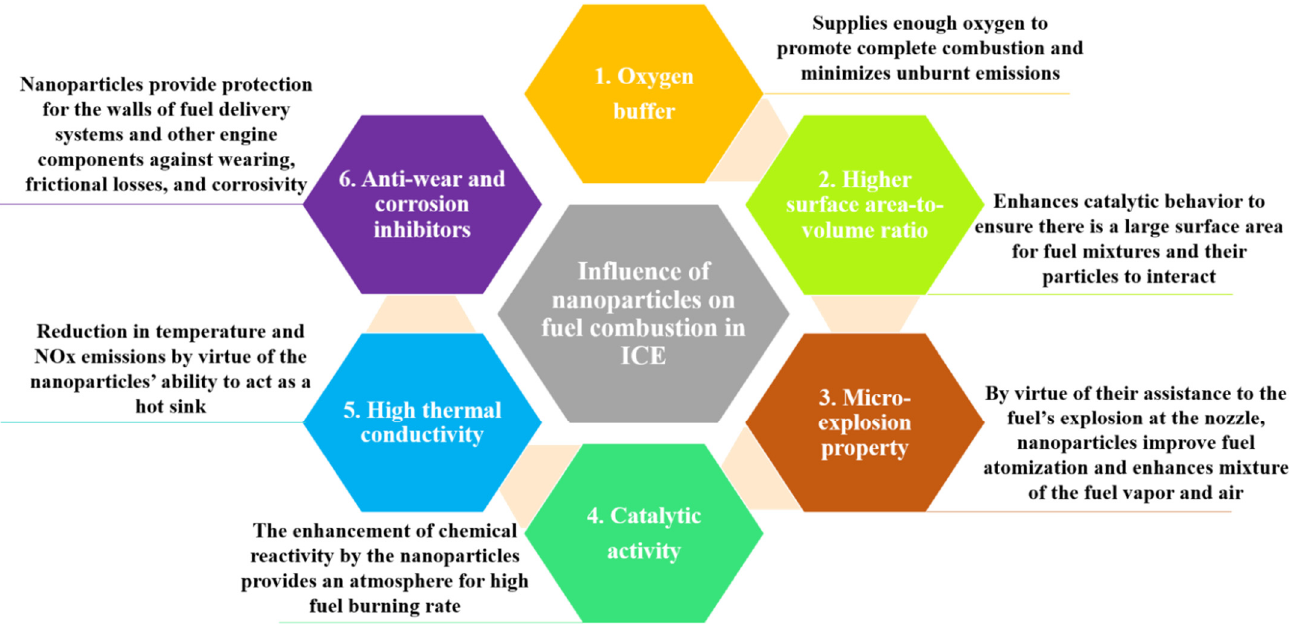
Figure 6. Characteristics of nanoparticles in CI Engines (Reprinted with permission from Ref. [30] Copyright © 2020 Elsevier).